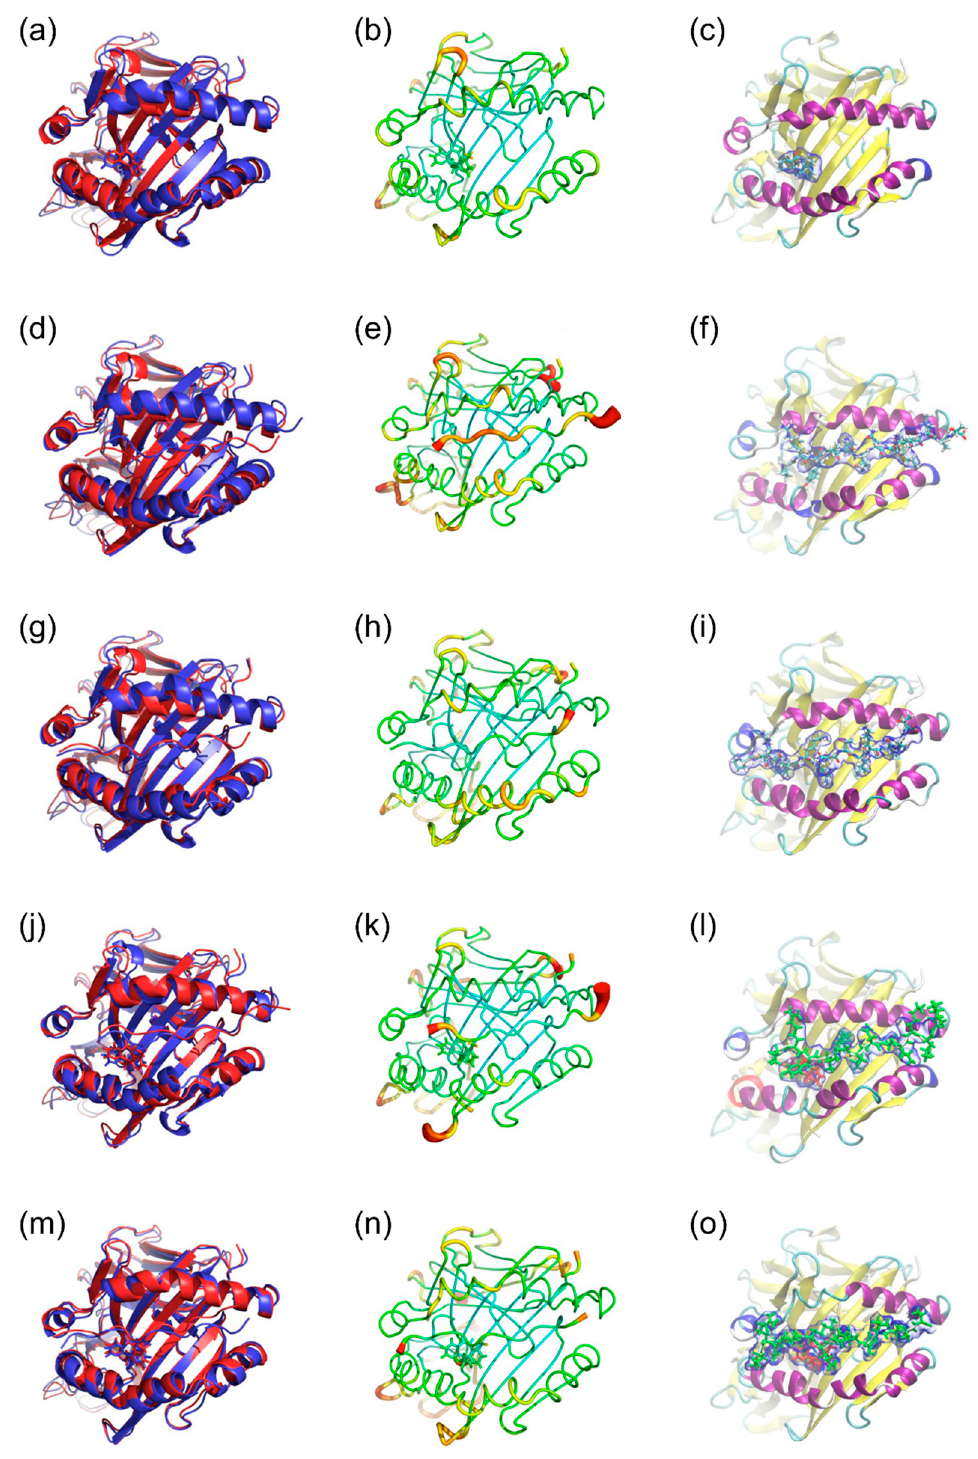
Figure 4. Simulated representative structures of nevirapine-bound HLA-DRB1*01:01 ( a – c ), hemagglutinin (HA) peptide-bound HLA-DRB1*01:01 in frame 2 ( d – f ) and frame 3 ( g – i ), and nevirapine-bound HLA-DRB1*01:01-HA peptide in frame 2 ( j – l ) and frame 3 ( m – o ). ( a , d , g , j , m ): Alignment of initial structure ( red ) and representative structure ( blue ); ( b , e , h , k , n ): Sausage plot of the structure, where the color and thickness of HLA-DRB1*01:01 are proportional to the RMSF of C α ; and ( c , f , i , l , o ): The volume occupied by nevirapine and HA peptide. The blue envelope outlines the 50% occupancy volume of nevirapine ( red ) and HA peptide ( green ).